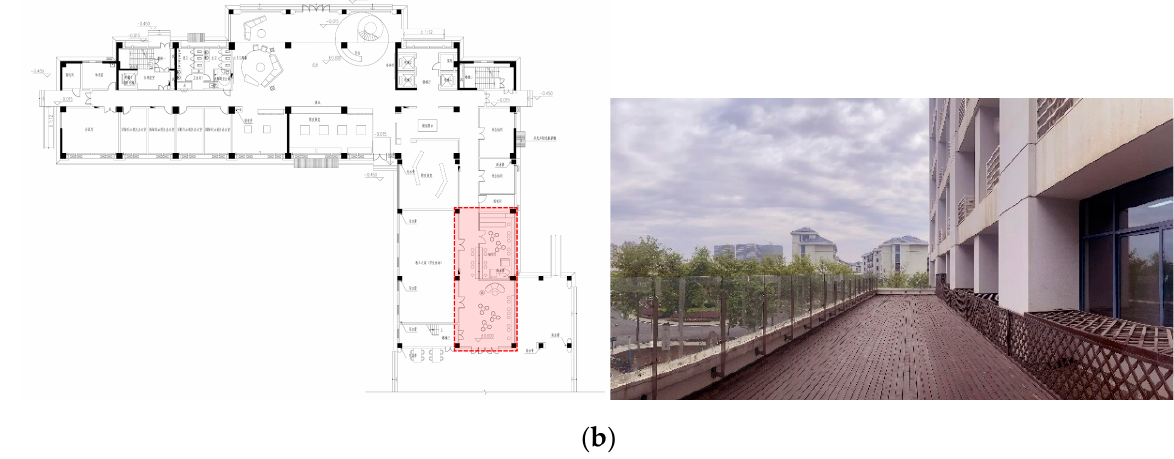
Figure 4. The third-floor terrace before optimization. ( a ) Original plan. ( b ) Photo.